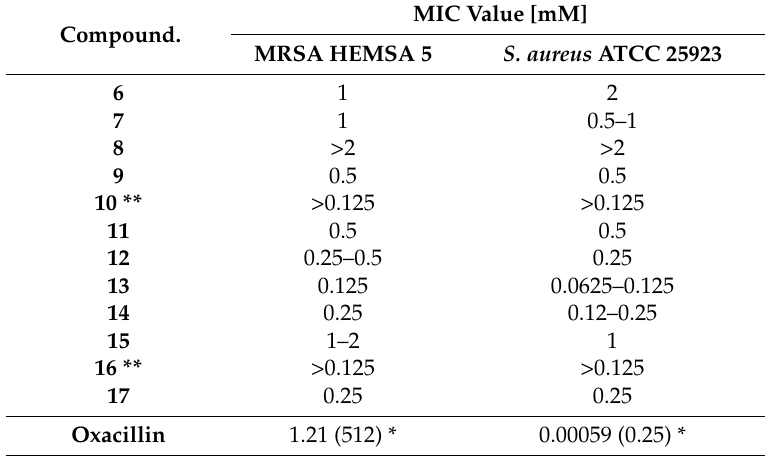
Table 3. Intrinsic antibacterial activity of compounds tested against S. aureus strains used in the study.